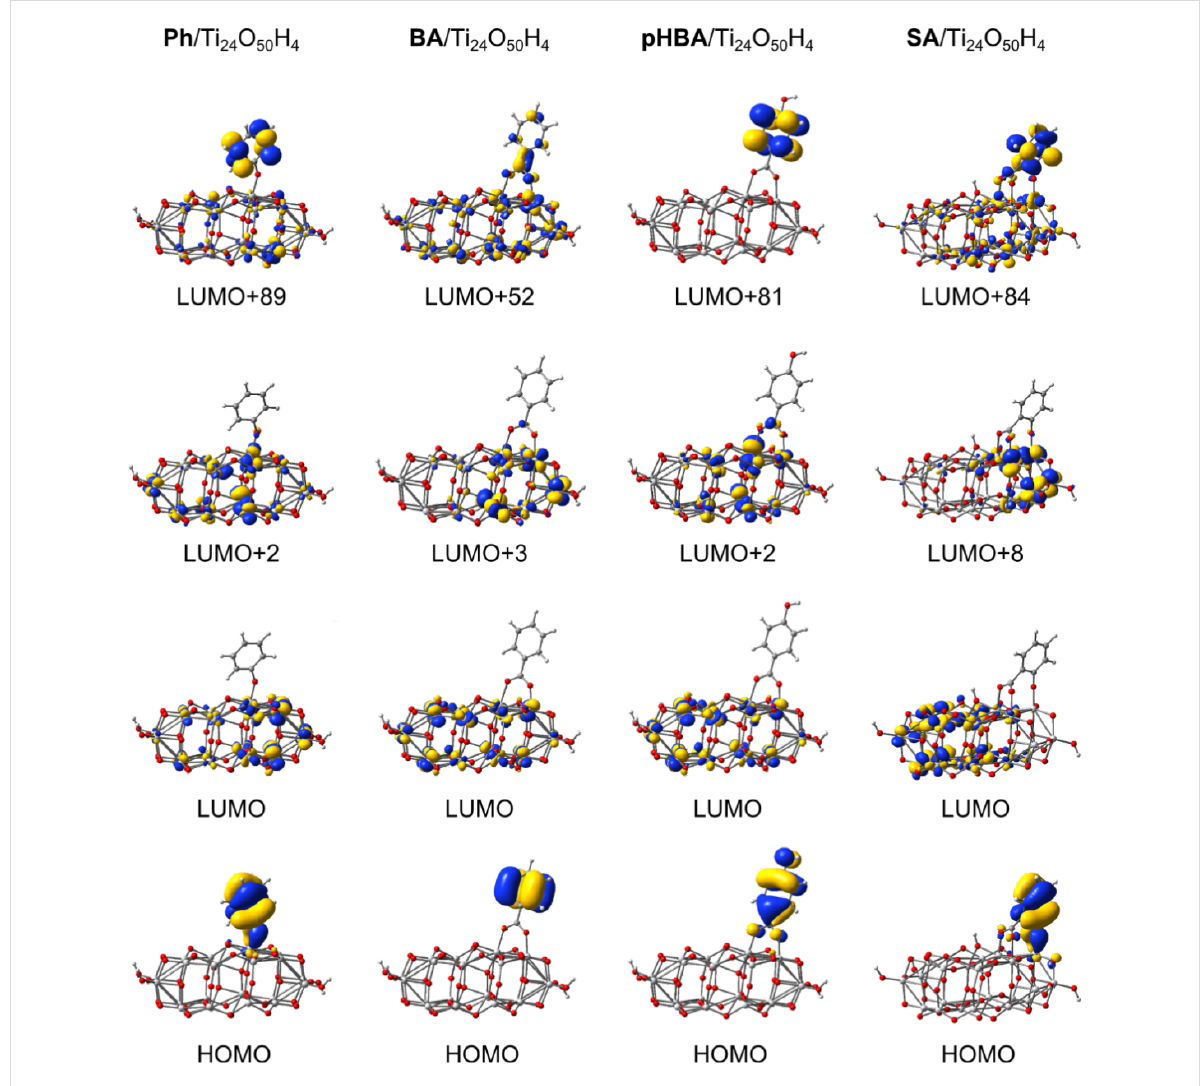
Figure 8: Isodensity surfaces (0.03 e /bohr 3 ) of the key molecular orbitals of the deprotonated and adsorbed forms of pollutants, calculated at DFT/ B3LYP/DZVP level in